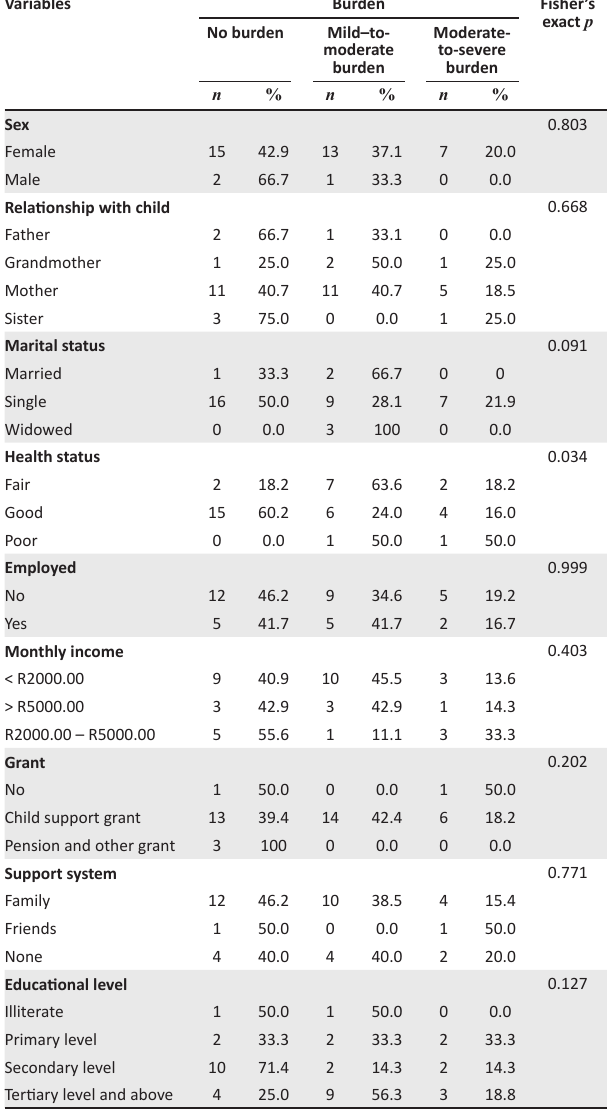
TABLE 1: Demographic profile and burden of care scores.